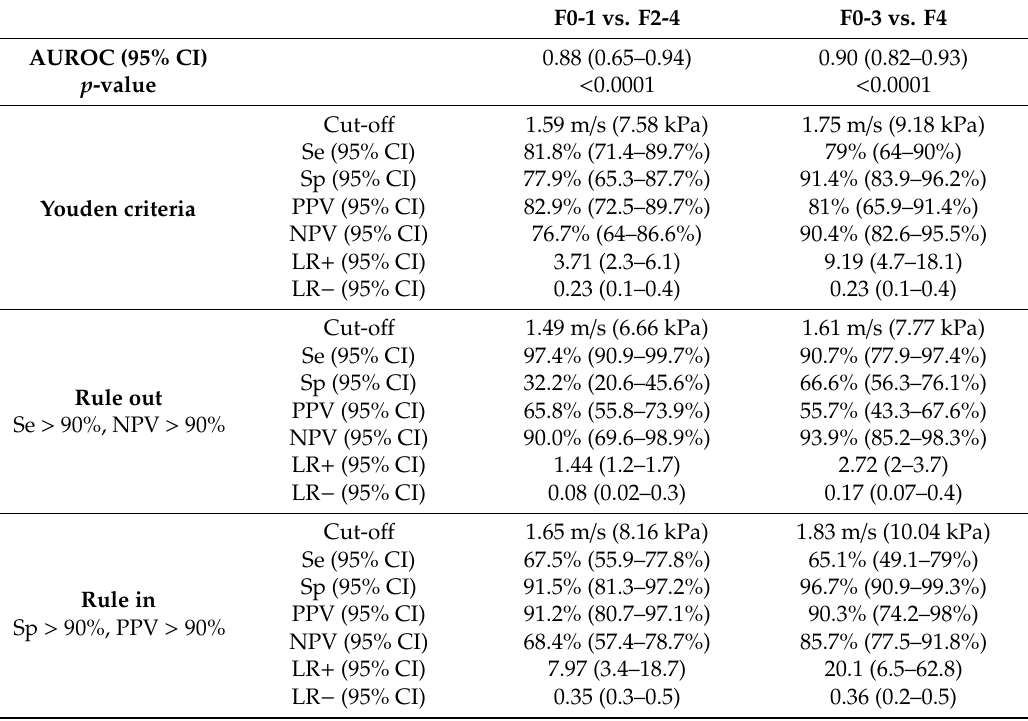
Table 3. Diagnosing performance of LSM evaluated by means of THE for various stages of fibrosis, using VCTE as reference the method.